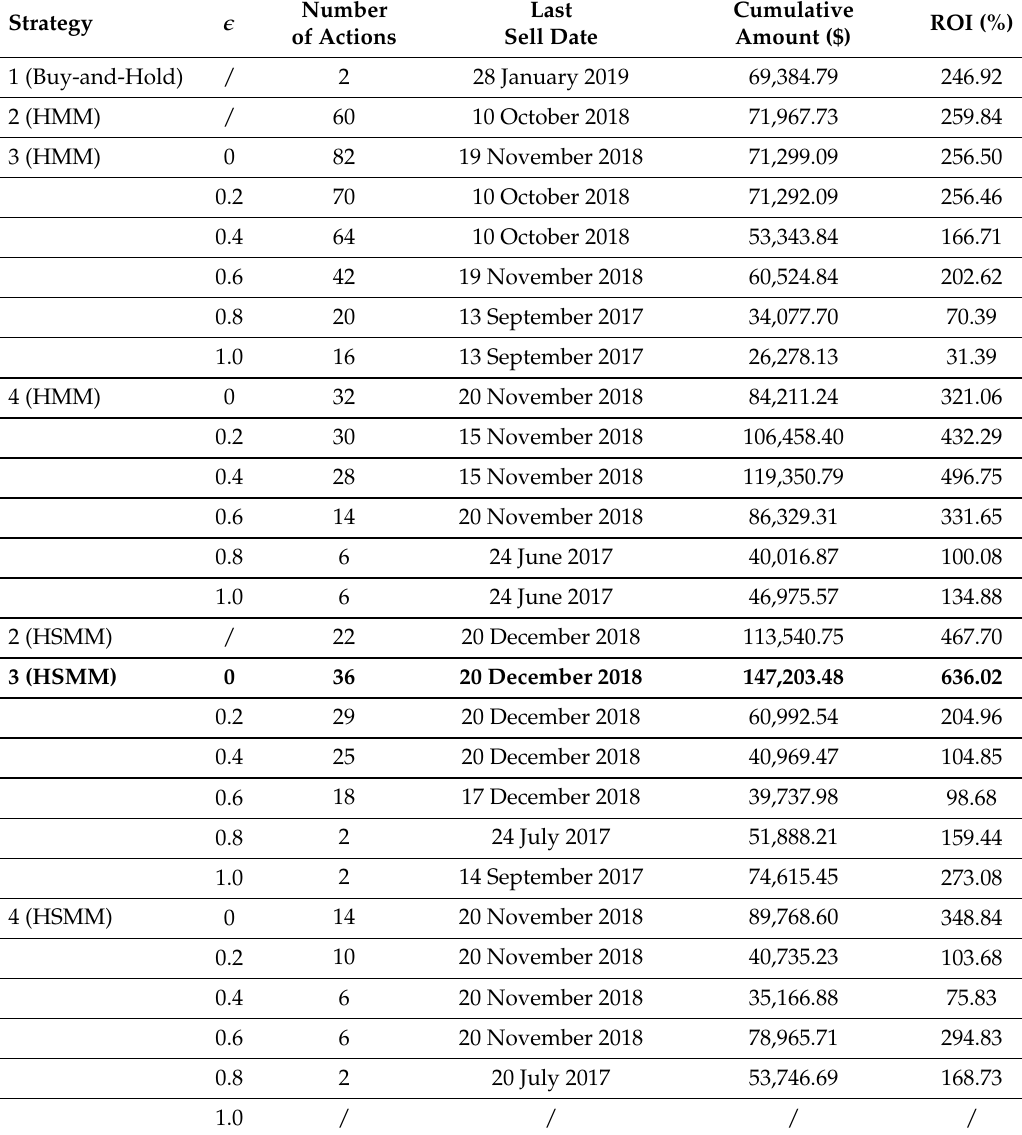
Table 7. Investment metrics for buy-and-hold and HMM- and HSMM-based strategies during the testing period of 1 January 2017–28 January 2019 for BTC/USD. Best strategy marked in